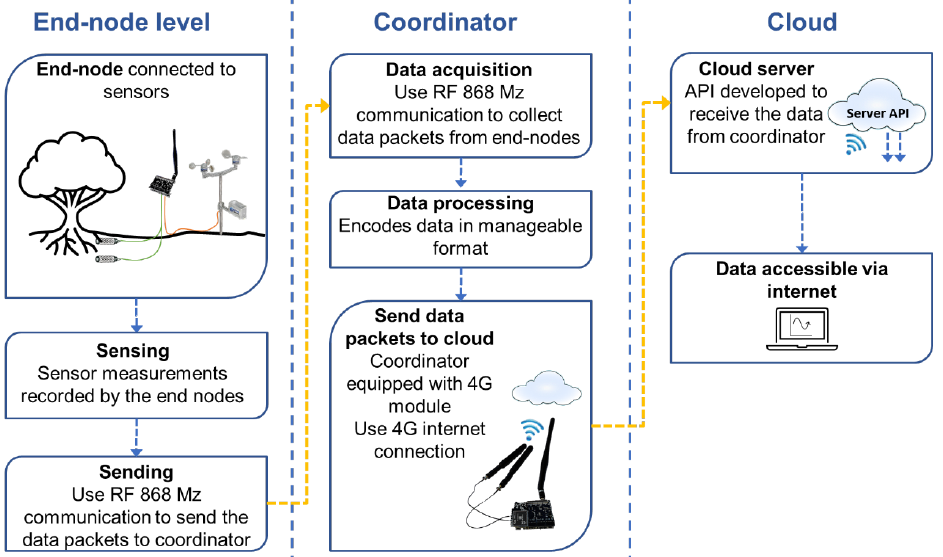
Figure 2. Wireless sensing system flow description.